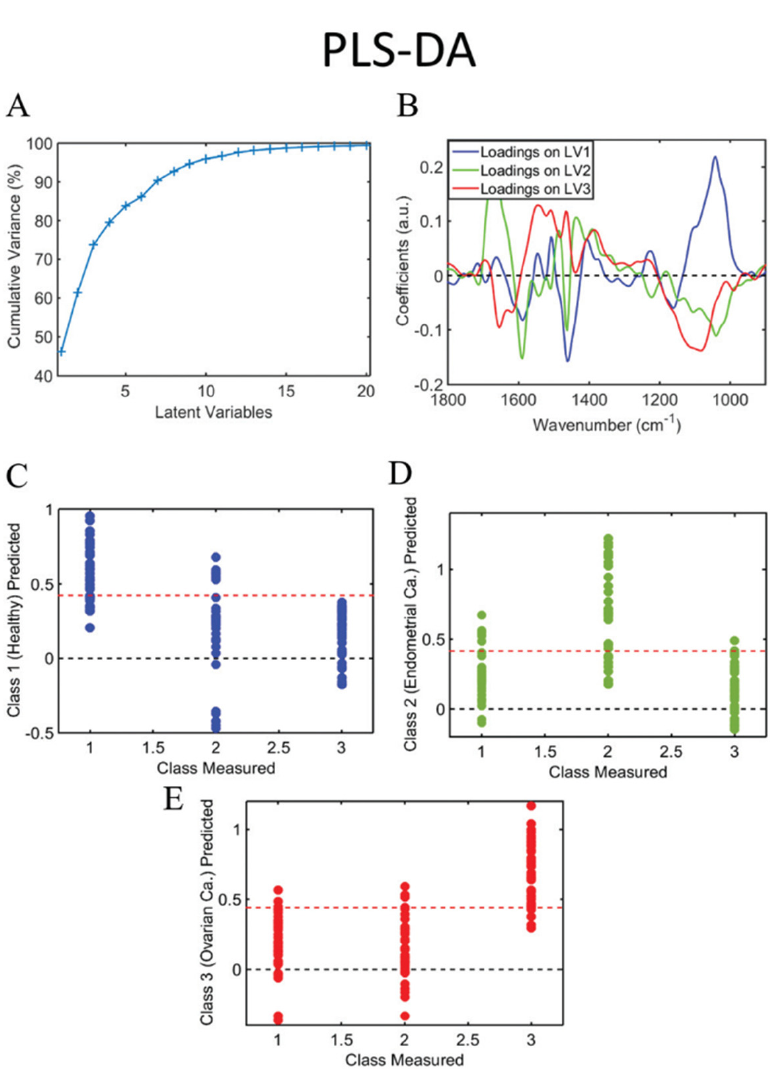
Figure 5. Cumulative explained variance using PCA ( A ); PCA loadings on PC1, 2 and 3 ( B ); predicted probability of healthy class versus endometrial and ovarian cancer ( C ); predicted probability of endometrial cancer class versus healthy and ovarian cancer ( D ); predicted probability of ovarian cancer class versus healthy and endometrial cancer ( E ). Class measured 1 = healthy control; 2 = endometrial cancer; 3 = ovarian cancer. PC: principal component. Picture reproduced with permission from “ Potential of mid-infrared spectroscopy as a noninvasive diagnostic test in urine for endometrial or ovarian cancer ”, Analyst, Paraskevaidi M. et al. 2018 [72].